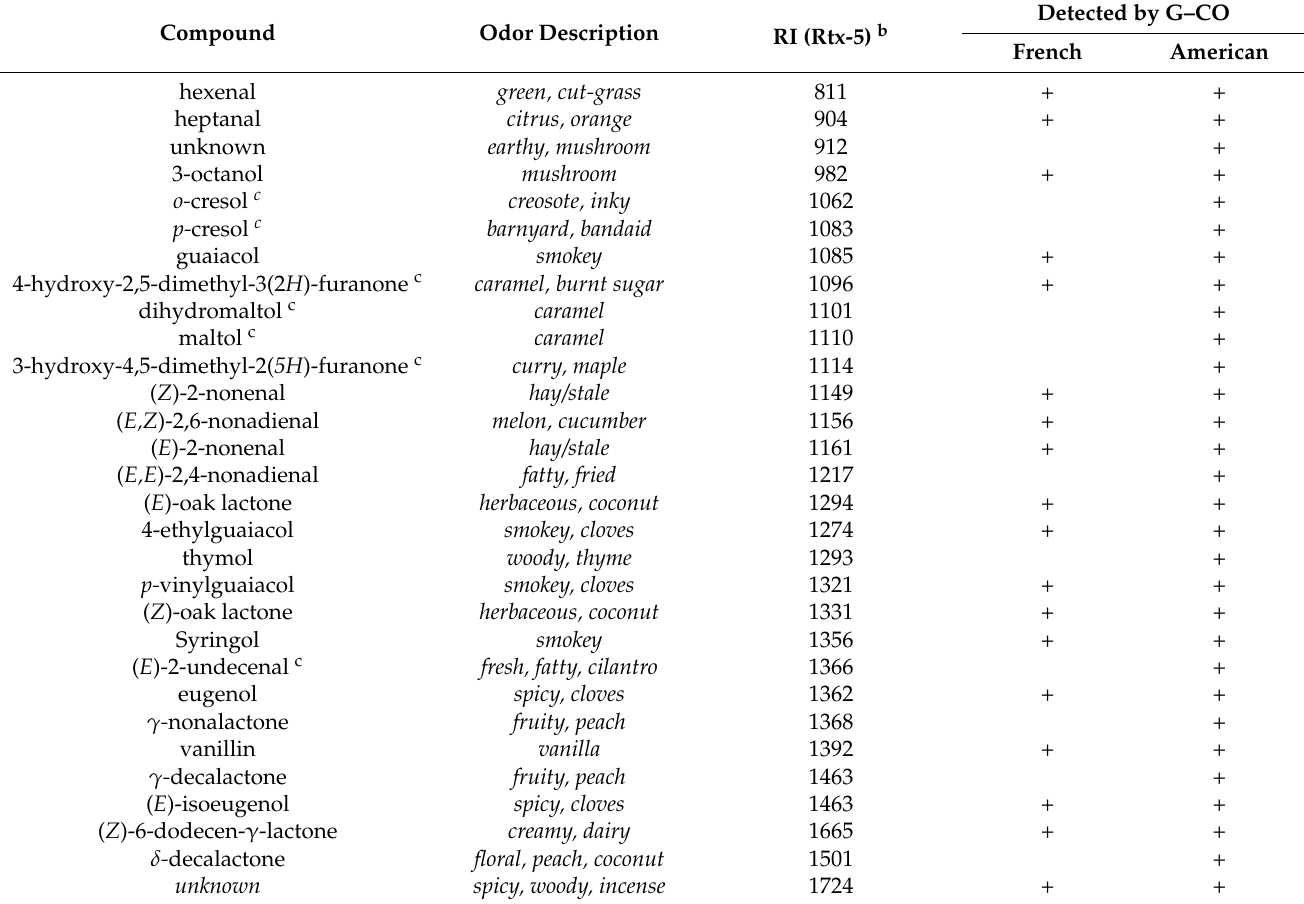
Table 1. Odor-active compounds extracted a from toasted American and French oak woods.